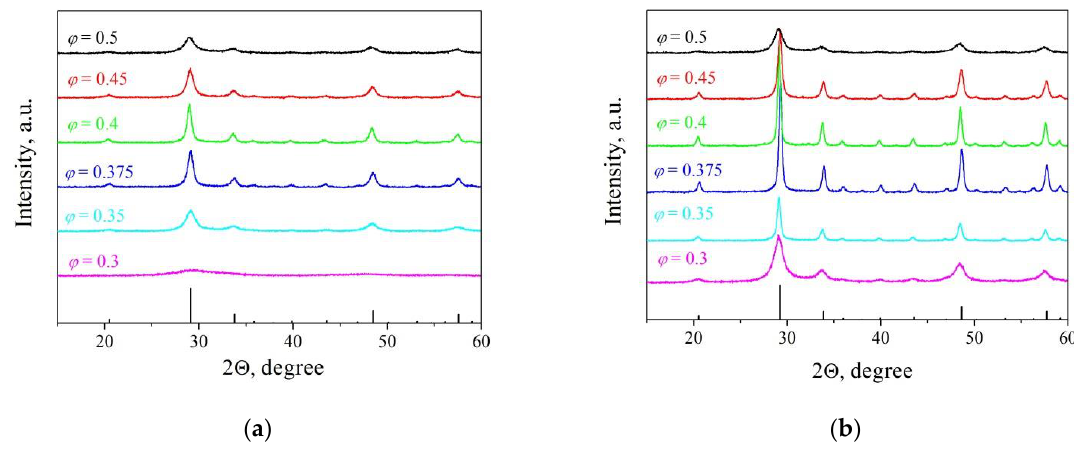
Figure 2. XRD patterns of ( а ) Y 2 O 3 – and ( b ) Y 2 O 3 – LiF nanopowders obtained by self-propagating high-temperature synthesis (SHS). high-temperature synthesis